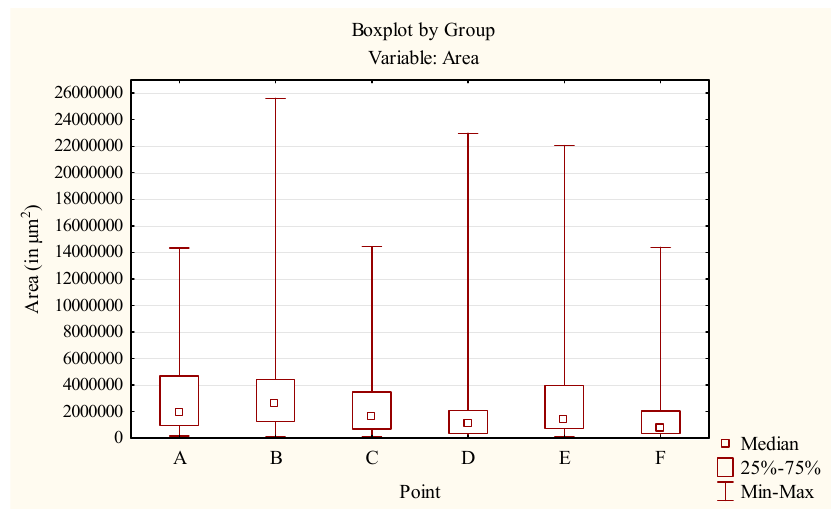
Figure 8. Group box plot for area variable (in μ m 2 ).